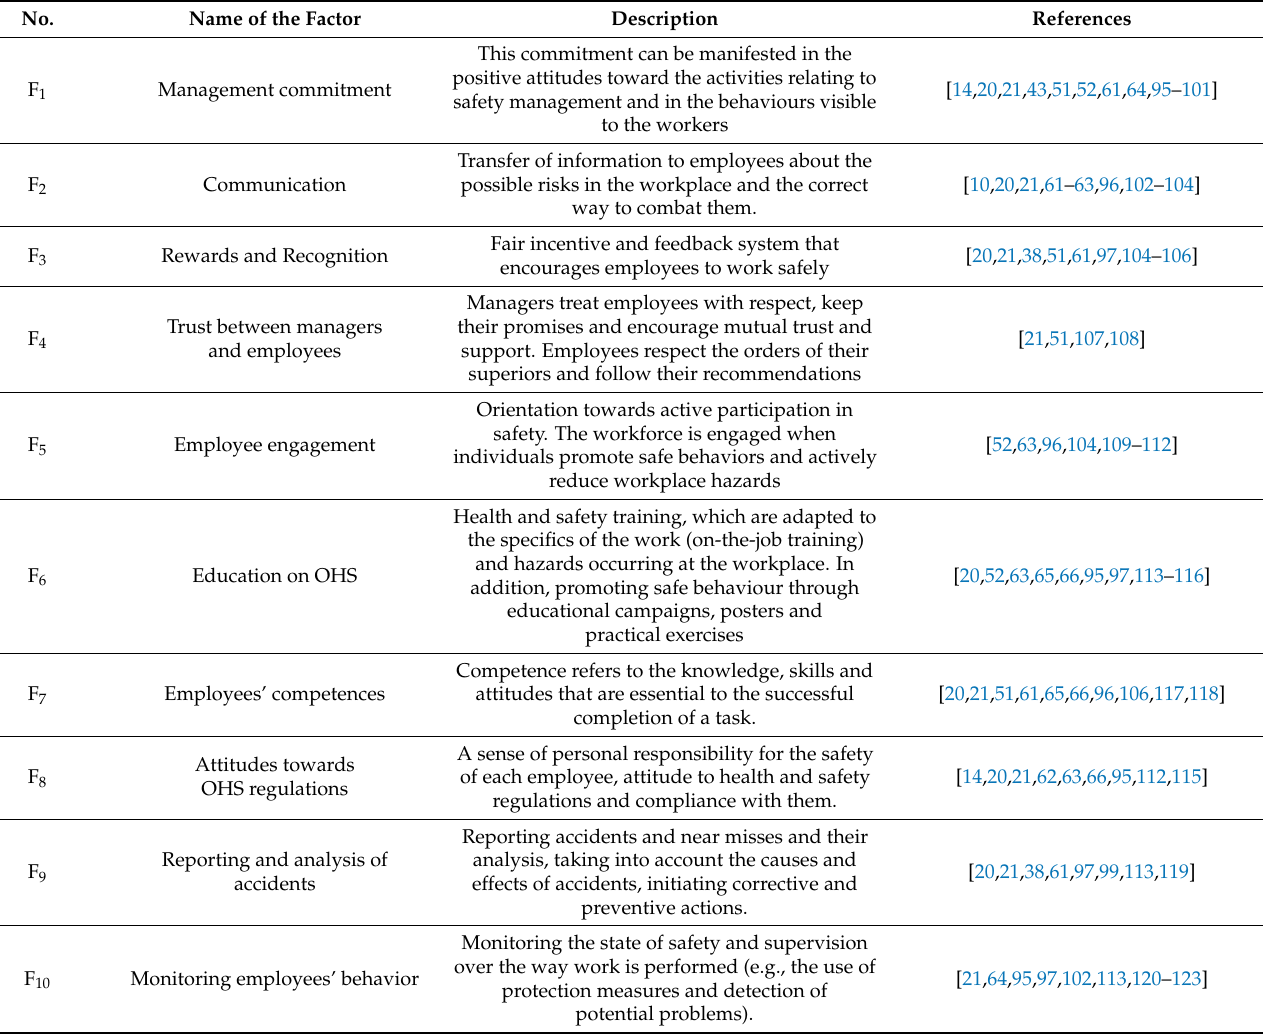
Table 7. The factors affecting safety